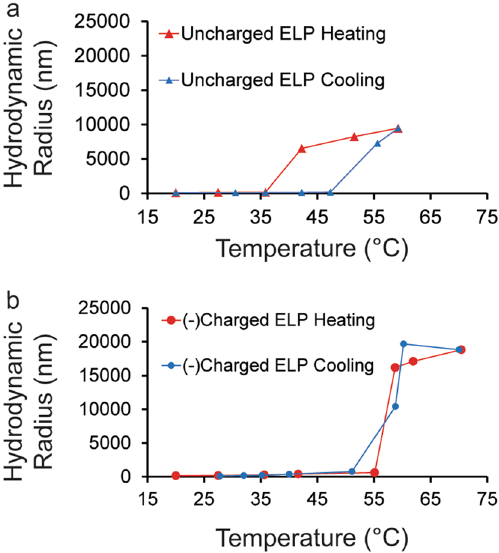
Figure 1. Uncharged ELP (a, data represented as triangles) and (−)charged ELP (b, data represented as circles) in DI water display reversible transition behavior. The average hydrodynamic radius of three accumulations is measured as the temperature of 10 µg/mL solutions of ELP is raised from 20 °C to 60 °C and 70 °C respectively (heating data shown in red) and cooled back down to 20 °C and 27 °C respectively (cooling data shown in blue) at a rate of 2 °C per minute. Lines between data points are added to help the reader more clearly see the transition